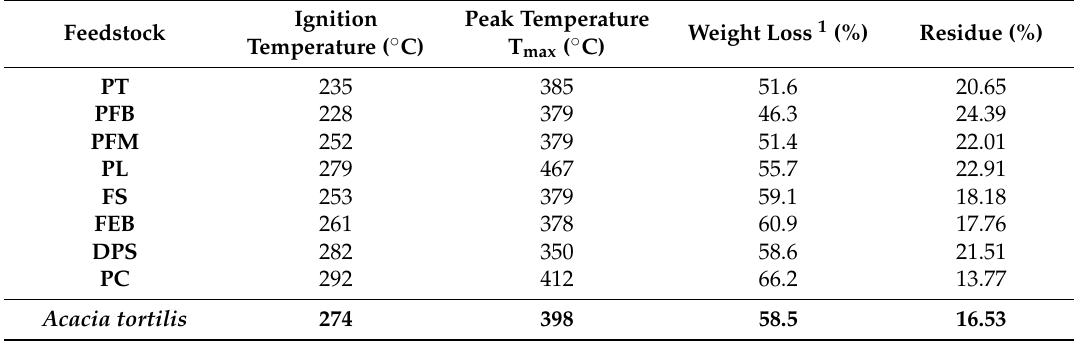
Table 4. Devolatilization * of the date palm residues and A. tortilis .